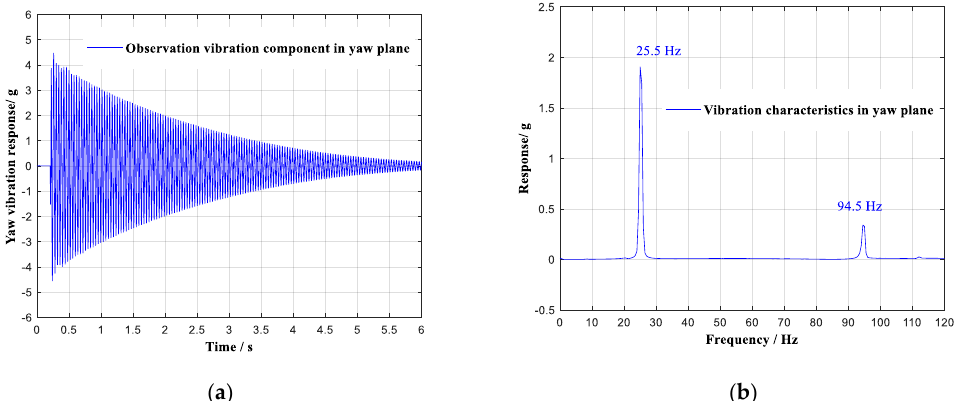
Figure 9. Vibration component of the selected stochastic vibration in the yaw plane. ( a ) Response in the time domain. ( b ) Response in the frequency domain.